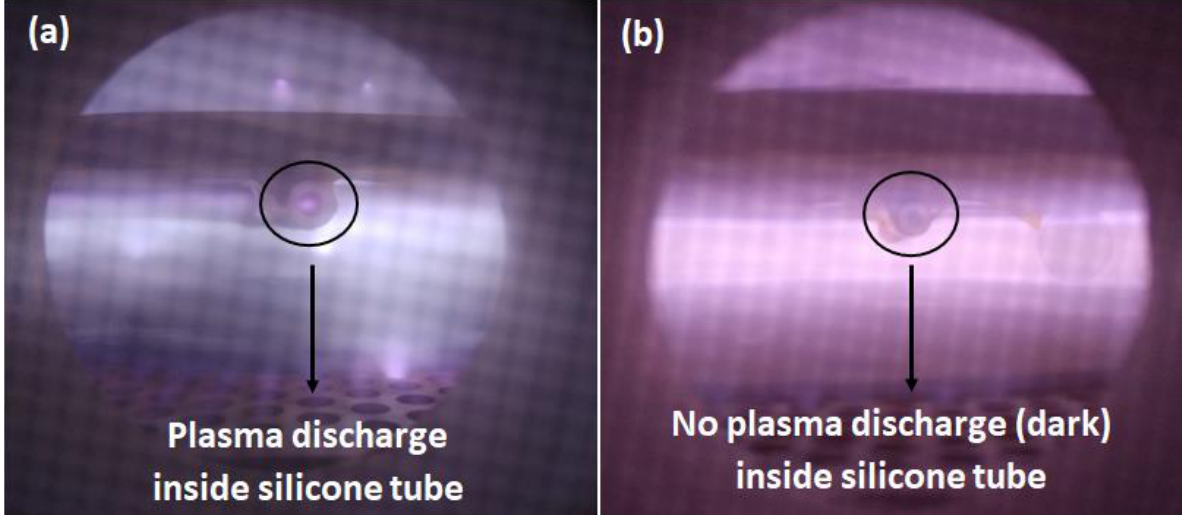
Figure 5. Pictorial view: ( a ) presence of plasma discharge inside the tube for 40% monomer concentration with RF power at 100 W; ( b ) no discharge (dark) inside the tube for 40% monomer concentration with RF power at 50 W.